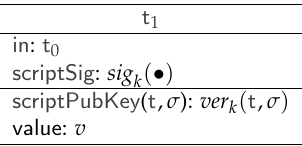
Figure 1. Simplified scheme of a Bitcoin